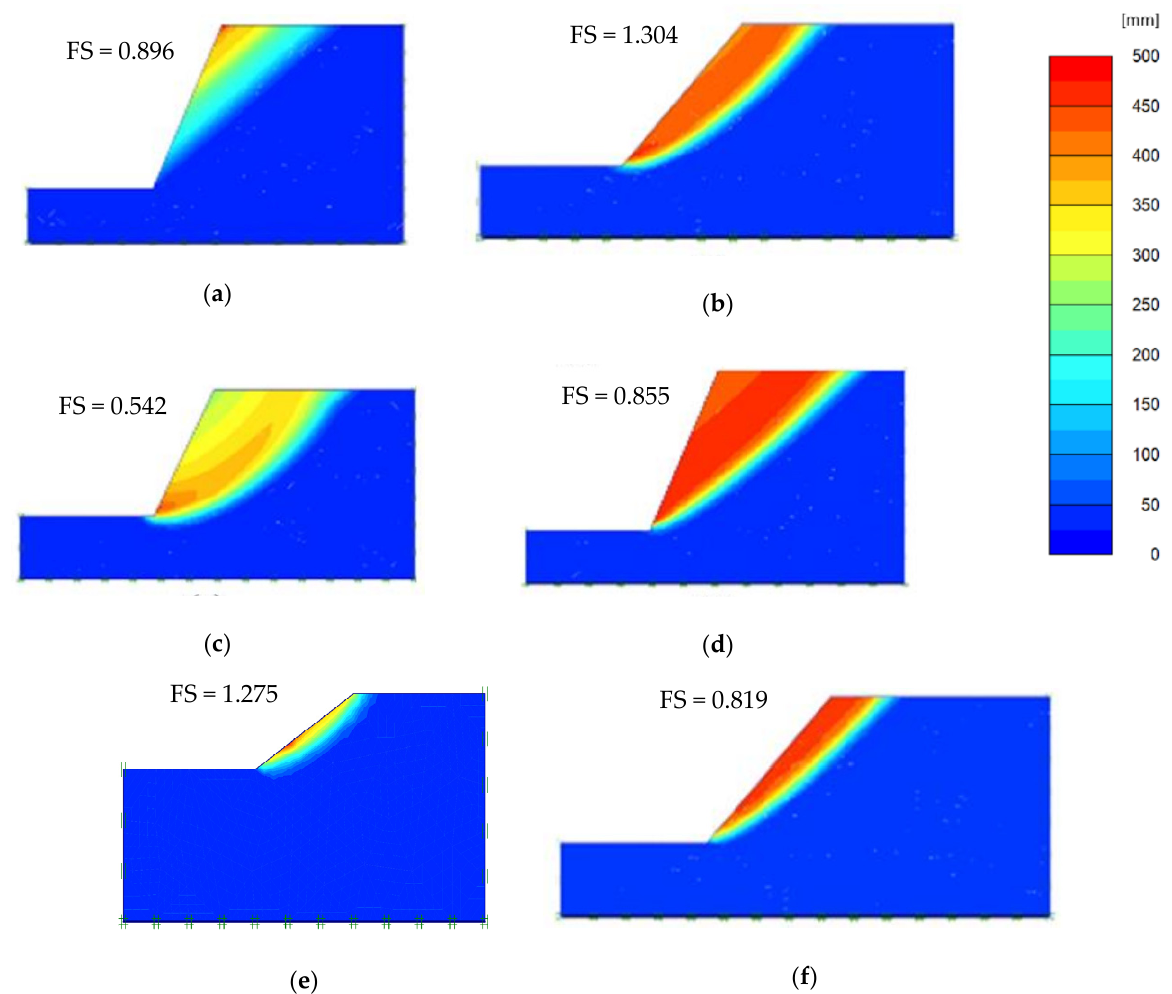
Figure 9. Failure surface from the numerical analysis: ( a ) shallow slope wedge failure and local failure for S-1; ( b ) toe general slope failure for S-2; ( c ) base failure for S-3; ( d ) toe general slope failure for S-4; ( e ) shallow surface slope failure for S-5; ( f ) slope toe, surficial failure for S-6. The contours indicate the displacement of the sliding soil mass. Table 3. The factor of safety and failure types from different slopes (S-1 through S-6). Sample ID